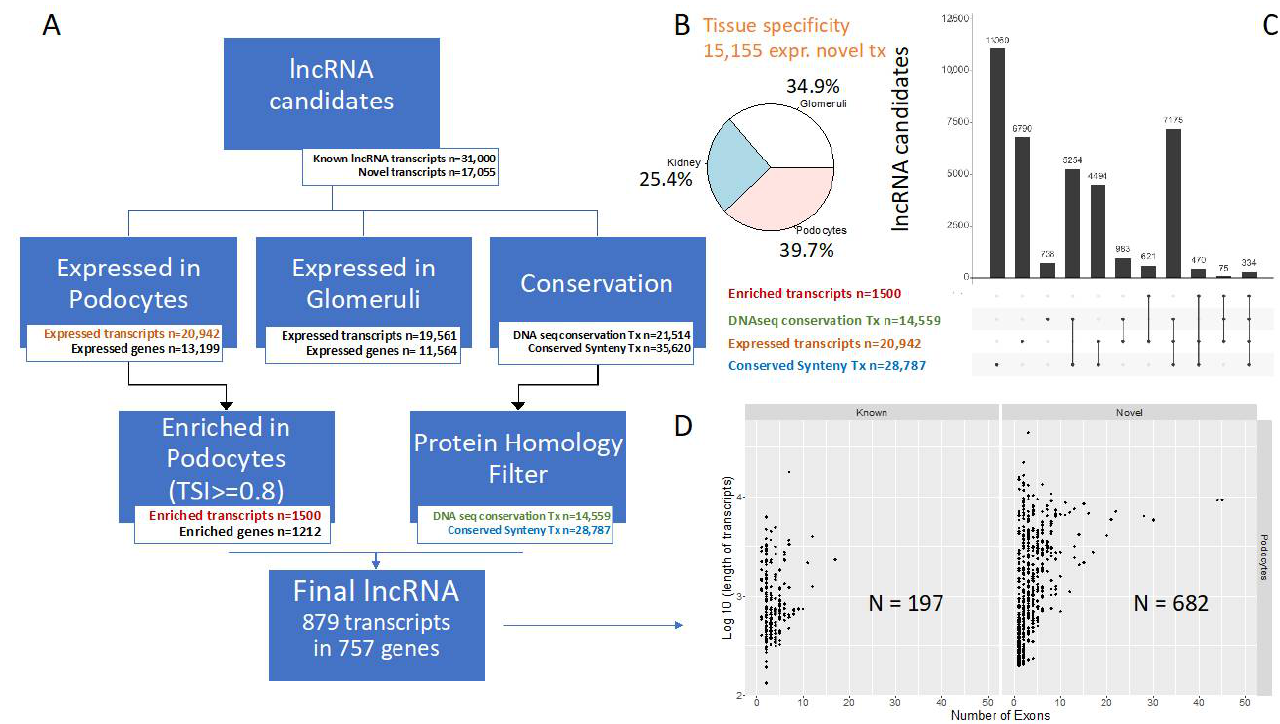
Figure 2. CALINCA identifies 879 conserved podocyte lncRNAs. ( A ) Our workflow to define the set of podocyte-specific lncRNAs (see Methods). A final set of 879 conserved and podocyte-specific lncRNAs is defined. ( B ) Tissue specificity of novel podocyte-expressed lncRNAs candidates. We identified 15,155 out of 20,942 expressed transcripts as novel (i.e., not represented in the reference annotation). The tissue specificity is defined by the maximal TSI value. ( C ) Stratification of lncRNA candidates by expression and conservation (see the colored tags in panel A). The overlap between different lncRNA candidate properties is shown as set intersections. ( D ) Transcript length and number of exons stratified by annotation status (known/novel) for the final set of 879 conserved and podocyte-enriched lncRNA transcripts.